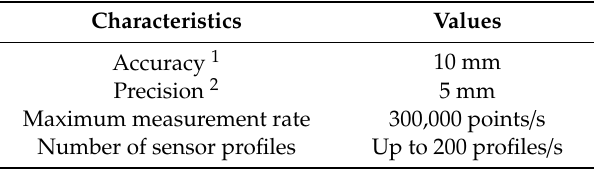
Table 1. Riegl VQ-250 sensor main characteristics.